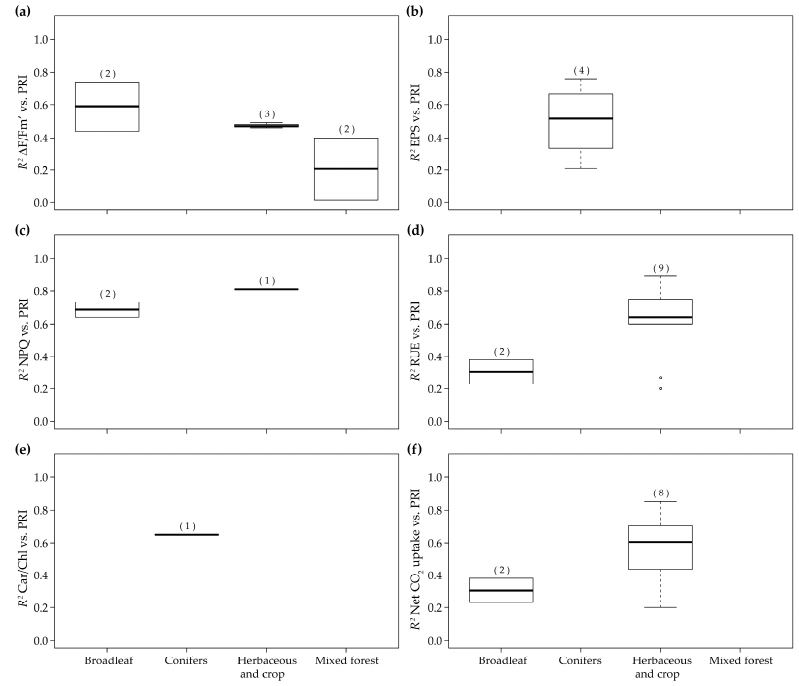
Figure 5. Boxplots of the coefficients of determination of the relationships between PRI and the physiological variables at the canopy level and diurnal timescale: ( a ) Actual photochemical efficiency ( Δ F/Fm’); ( b ) Epoxidation state of xanthophylls (EPS); ( c ) Non-photochemical quenching (NPQ); ( d ) Radiation-use efficiency (RUE); ( e ) Carotenoid/chlorophyll (Car/Chl); and ( f ) Net CO 2 uptake. Central lines represent medians, boxes represent 50% of the data, whiskers represent minima and maxima and circles represent outliers. The numbers of correlations reported in the literature are shown in brackets.